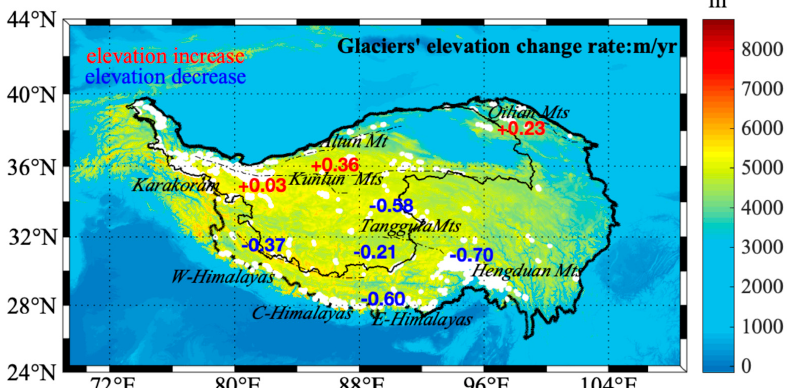
Figure 15. Elevation change rates (m / yr) of major glaciers on the Tibetan Plateau over the period from March 2003 to October 2009 are indicated by red and blue numbers (m / yr). Red and blue numbers are for increasing and decreasing glacier elevations, respectively. The black line across Tibet separates basins of endorheic and exoreic